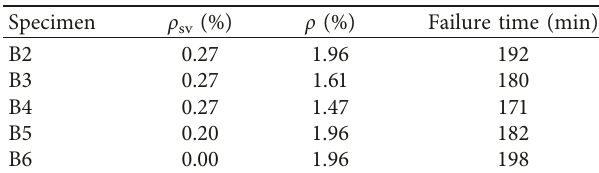
Figure 6: Measured temperature-time curves of the RC beam: (a) B2, (b) B3, (c) B4, (d) B5, and (e) B6. Table 4: Fire